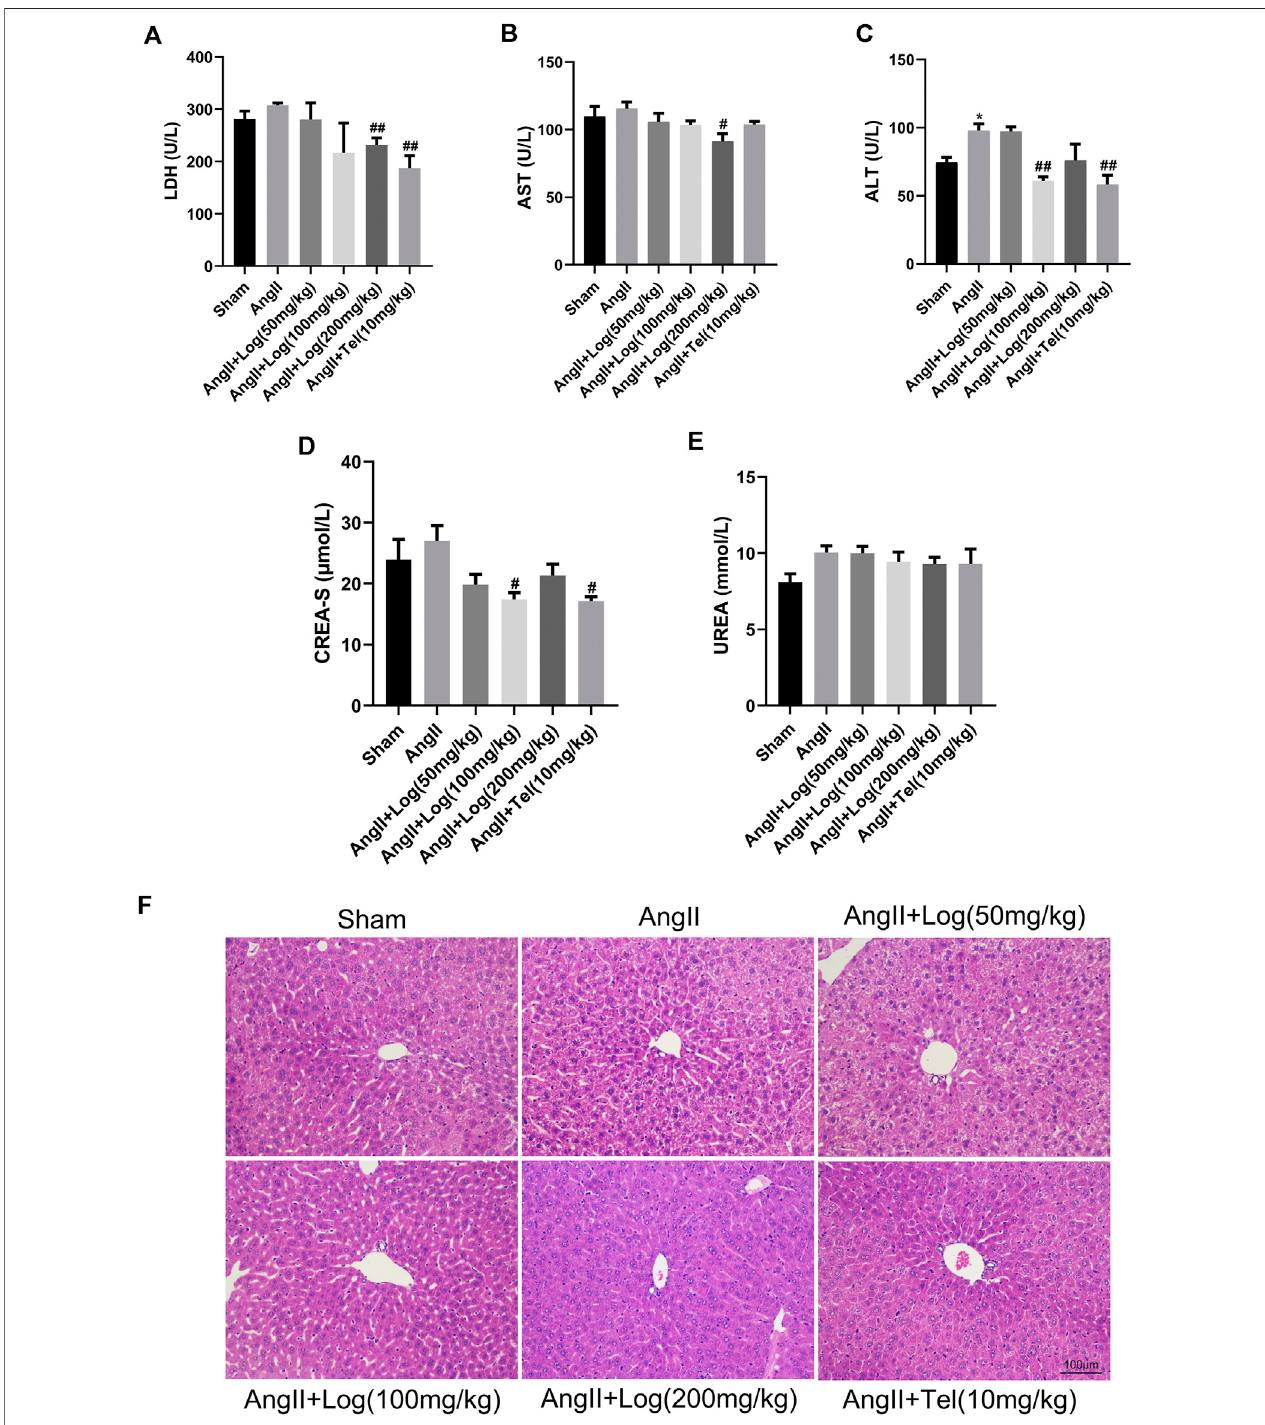
FIGURE5| Loganinhasnoobvioustoxicityorsideeffectsonnormal organs. (A – E) ThelevelsofLDH,AST,ALT,CREA-S,and UREAaretested fromtheserumof various mice groups ( n (cid:2) 3). (F) Liver histopathology is done by H&E staining. Scale bar (cid:2) 100 µm. Data are expressed as mean ± SD. * p < 0.05 vs the sham group; # p < 0.05, ## p < 0.01 vs the Ang II – treated group (analyzed using one-way ANOVA).